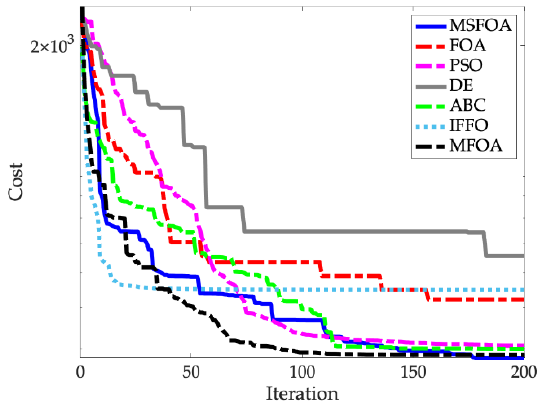
Figure 6. Convergence curves of the average best values for the second scenario.